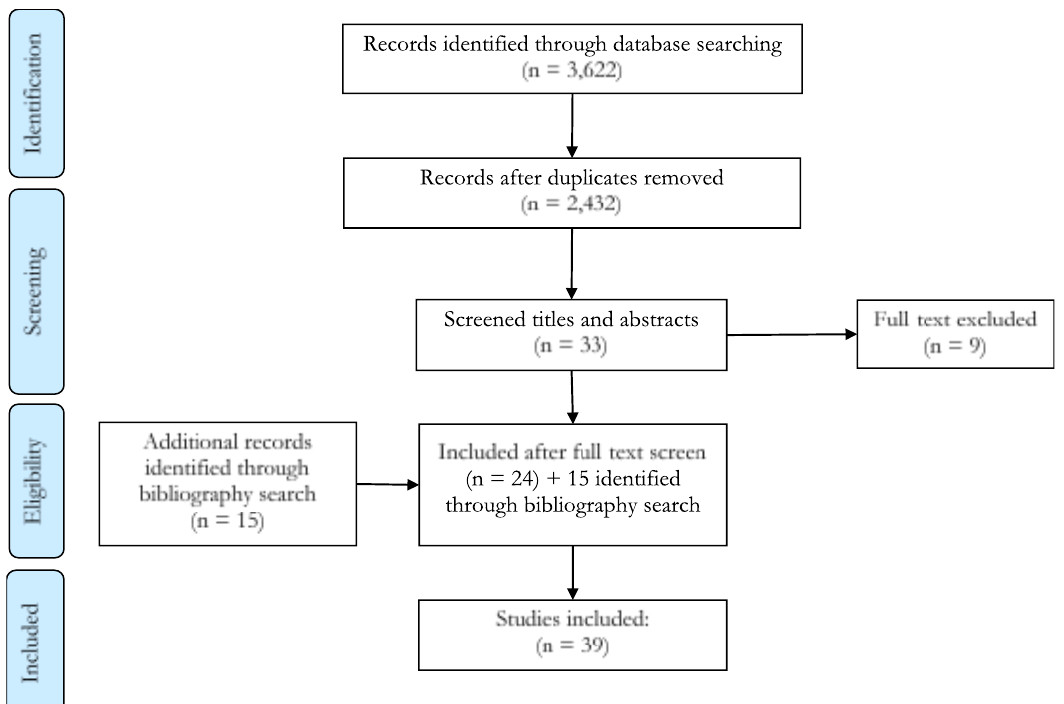
Figure 1. PRISMA (Preferred Reporting Items for Systematic Reviews and Meta-Analyses) flow diagram of the search and screening process for the current systematic review.